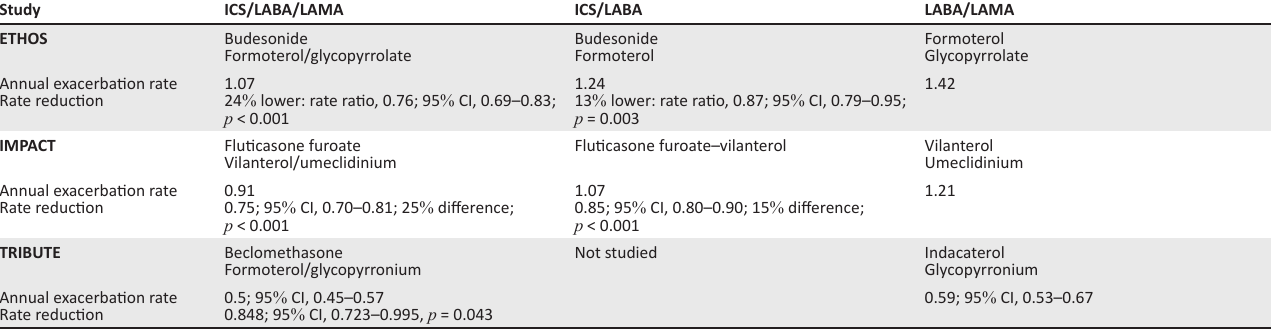
TABLE 2: Illustration of the effect of inhaled corticosteroids added to bronchodilators on reduction of exacerbations in chronic obstructive pulmonary disease. Study